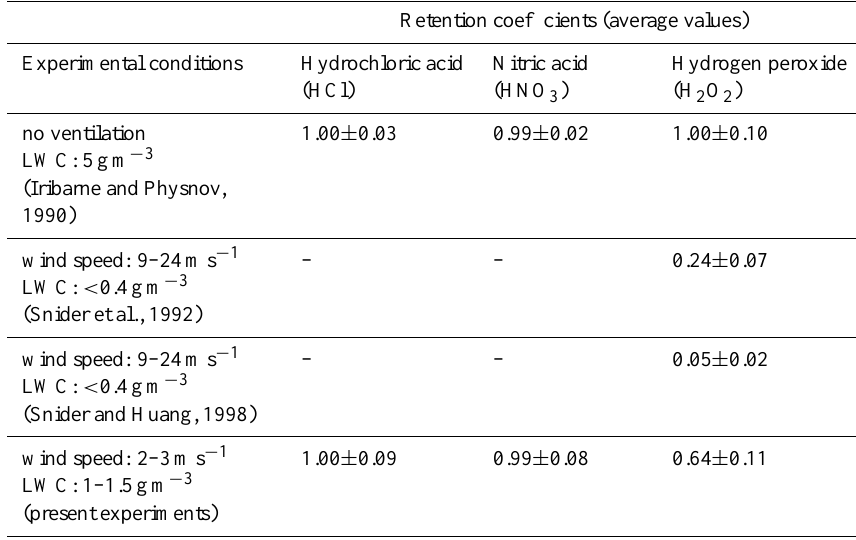
Table 3. Comparison of retention coefficients determined under various experimental